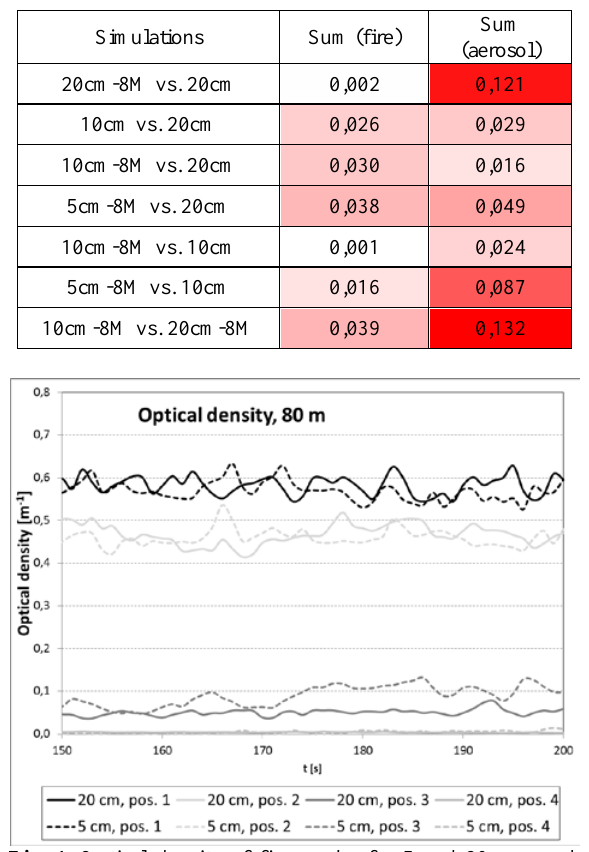
Fig. 4 . Optical density of fire smoke for 5 and 20 cm mesh resolution measured by quadruple of detectors at 80 m from the fire source after steady-state conditions are formed.